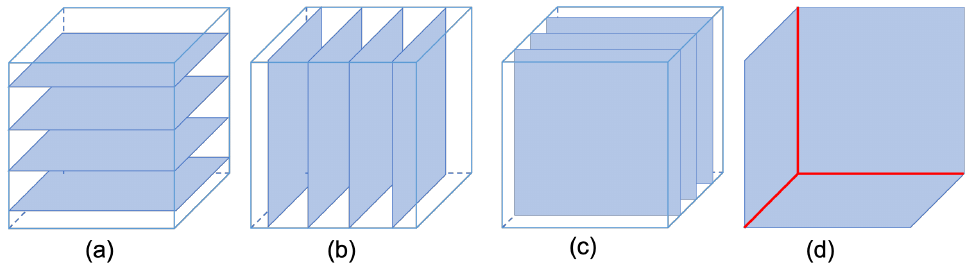
Figure 3: Procedure for calculating the GSD of the X-cube model on the 3-torus. (a- c) Decoupling 2D toric code layers (via a local unitary transformation) from the 3D bulk in x y , yz and zx planes. After removing all the foliation layers, the remaining minimal structure is composed of a 2D toric code layer in each direction, which are then coupled along the red intersection